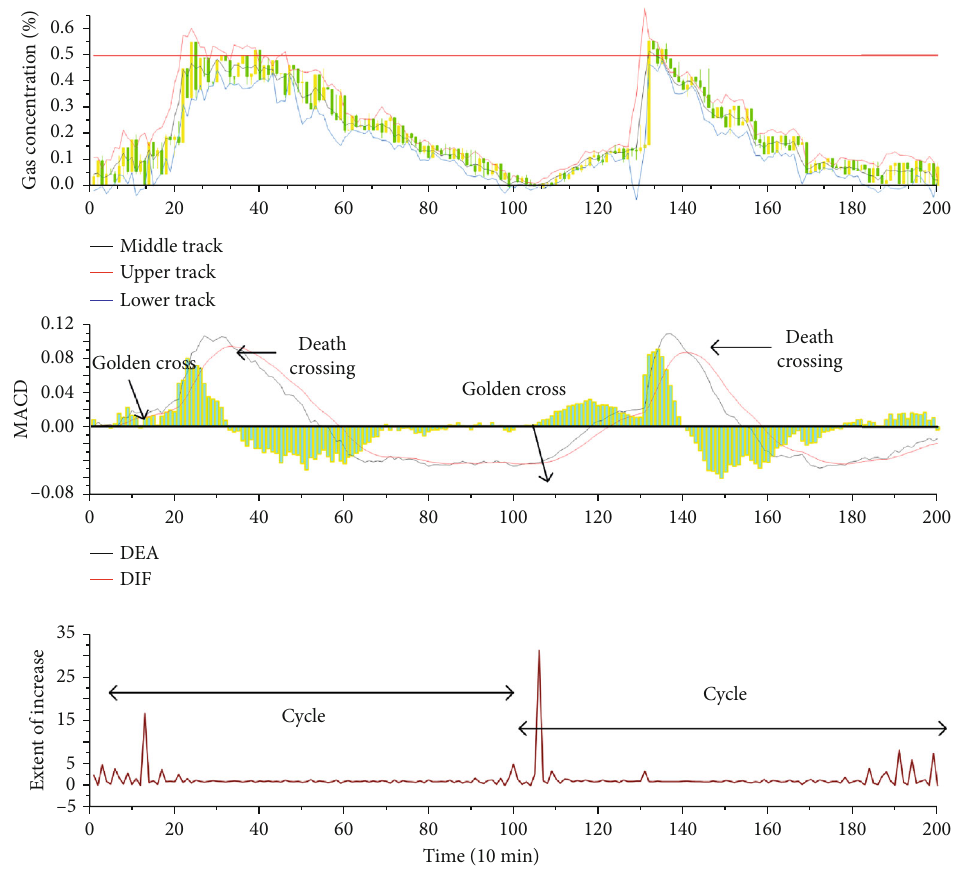
Figure 10: K-line and technical indexes of gas